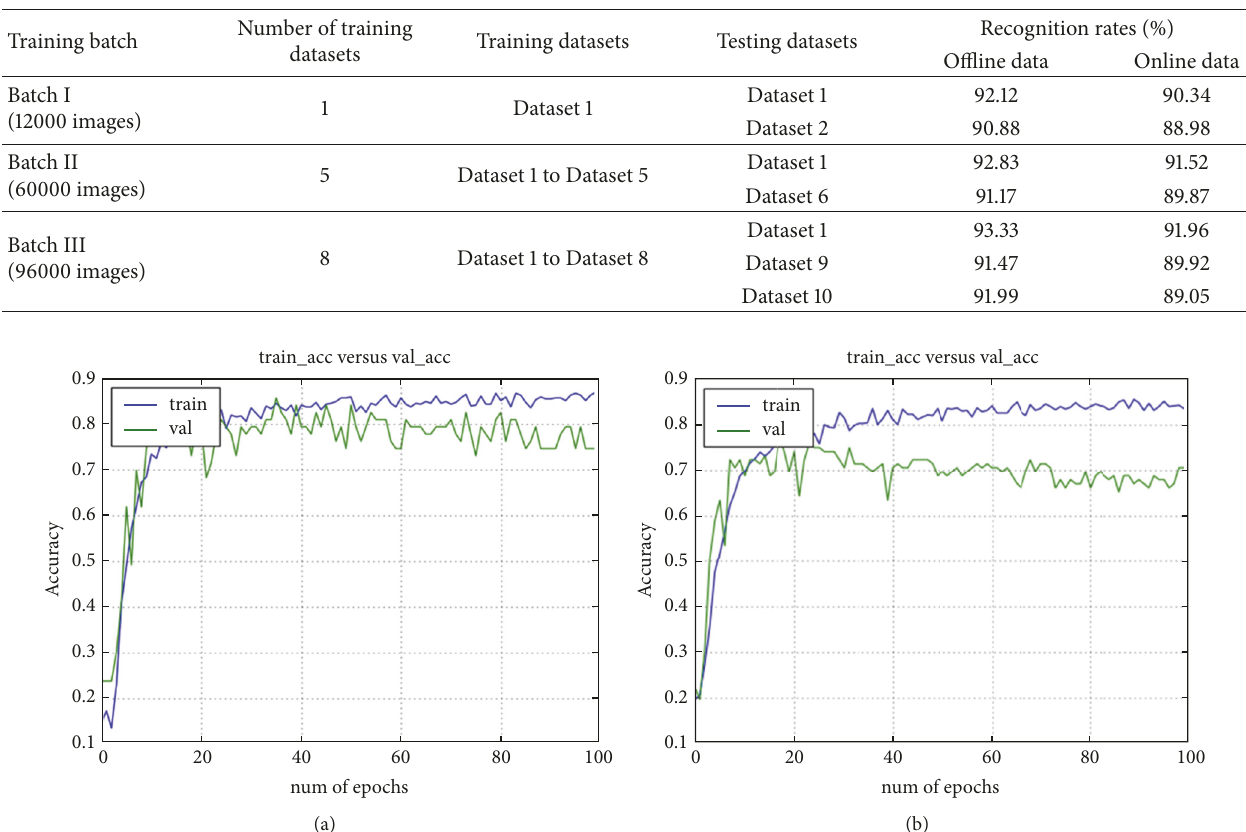
Table 2: Recognition rates in different CNN training cases with two testing conditions.